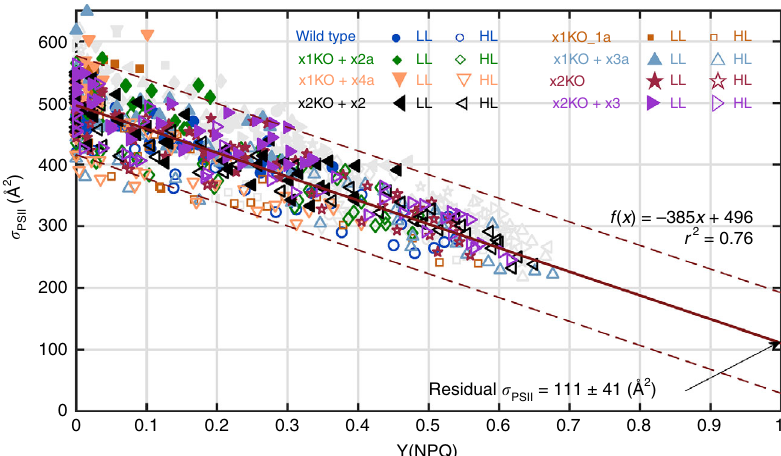
Fig. 5 σ PSII vs Y(NPQ) from rapid light curves and the corresponding linear regression. Individual data points of all measured strains cultivated both under low light (six biological replicates each) and high light ( fi ve biological replicates each). In order to discern Lhcx and Dt-dependent qE processes from qI processes, data points where an increase of Y(NPQ) did not lead to a further downregulation of σ PSII are not included in the regression calculation, but indicated in light gray. This was determined by calculating the percent change of each σ PSII from its previous light step. If σ PSII decreased by < 5% of the total measured decrease for that curve while Y(NPQ) increased, it was omitted. Data points above 600 µ mol photons m − 2 s − 1 and data points with a negative Y(NPQ) were also removed. A linear regression line, the 95% con fi dence interval, the regression equation and the r 2 are indicated. Source data are provided as a Source Data fi